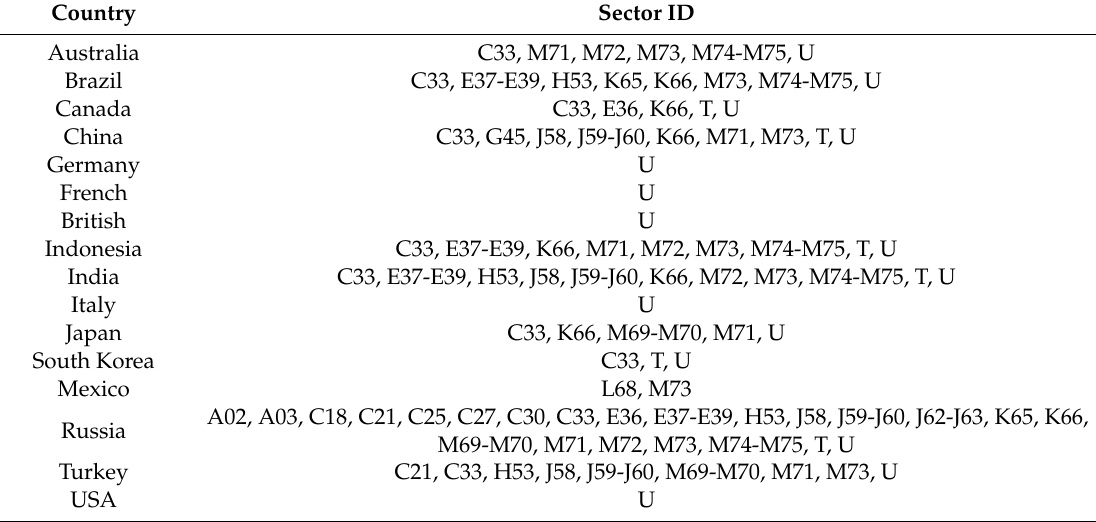
Table A4. Sectors in which G20 countries have zero output, value added, and final demand in 2014. Country Sector